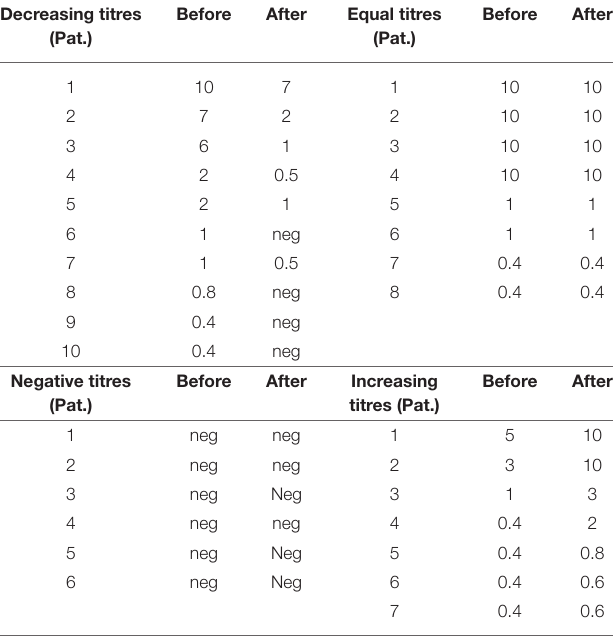
TABLE 2 | Development of NAB titres in 31 patients before and after incoBoNT/A. Decreasing titres